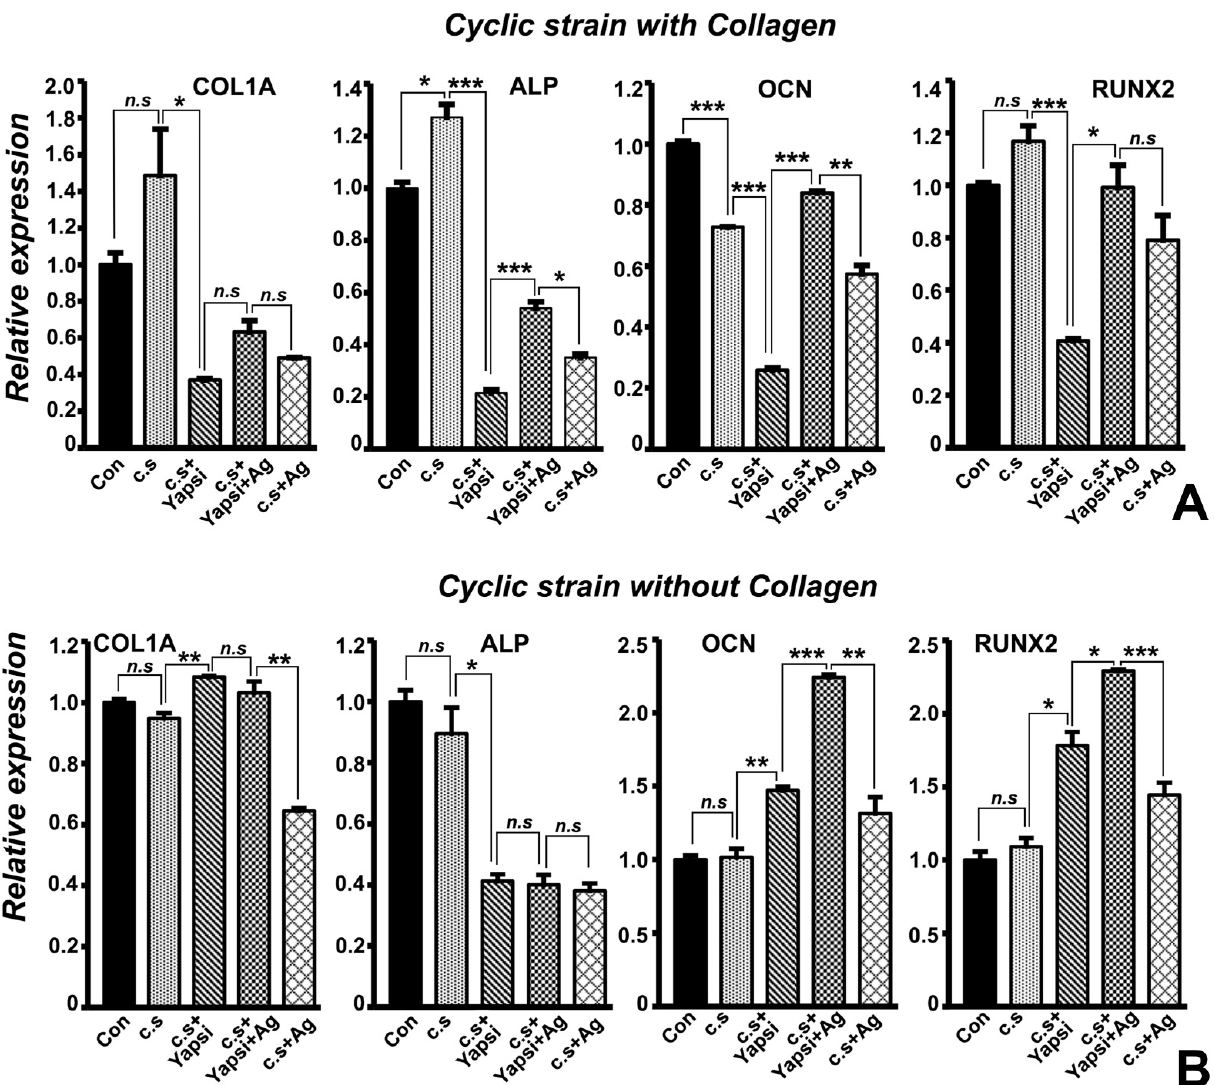
Figure 3. Gene expression analysis for select mineralization and differentiation markers in PDL cells subjected to cyclic strain and controls. Representative RT-qPCR analysis of expression levels for COL1A, ALP, OCN, and RUNX2 in PDL cells grown with collagen ( A ) and without collagen ( B ). Transcript levels for each gene were normalized to β -actin transcript levels. Data are presented as fold difference of expression levels for each experimental treatment condition when compared to cells not subjected to any mechanical strain (Con). Graphs are representative of three independent PCR analysis obtained from at least three experiments for each treatment condition. Addition of agrin rescued ALP, OCN, and RUNX2 transcript levels specifically for PDL cells grown on collagen-coated surfaces ( A ). Con—control; c.s—cyclic strain; Yapsi—YAP1 siRNA treatment; Ag—agrin. t test for statistical level of significance; *, p < 0.05; **, p < 0.01; ***, p < 0.005. n.s —not significant.